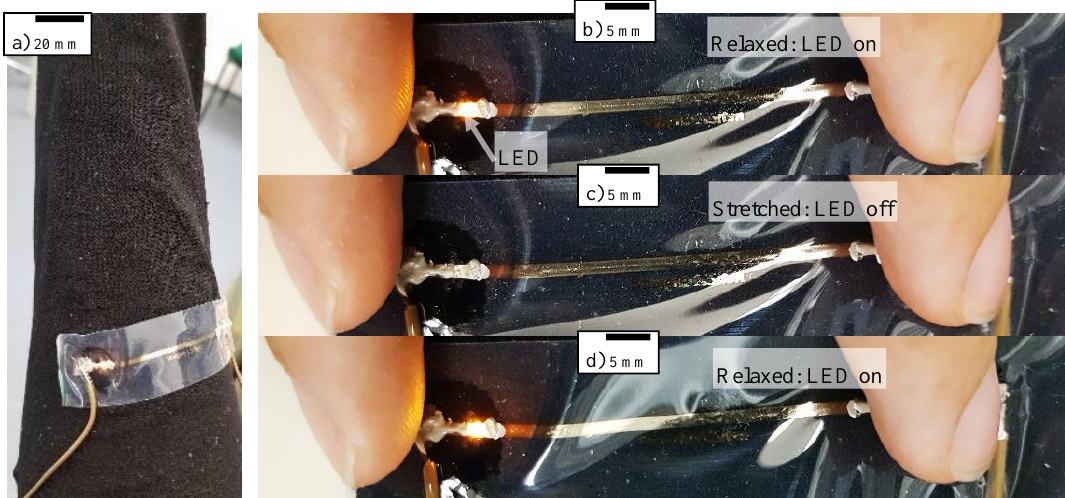
Figure 9. ( a ) Stretchable wire attached to tights with connecting wires and a light emitting diode (LED). The LED is lighting in the relaxed position ( b ), not lighting in a stretched state ( c ), and again lighting when returning to the relaxed position ( d ).